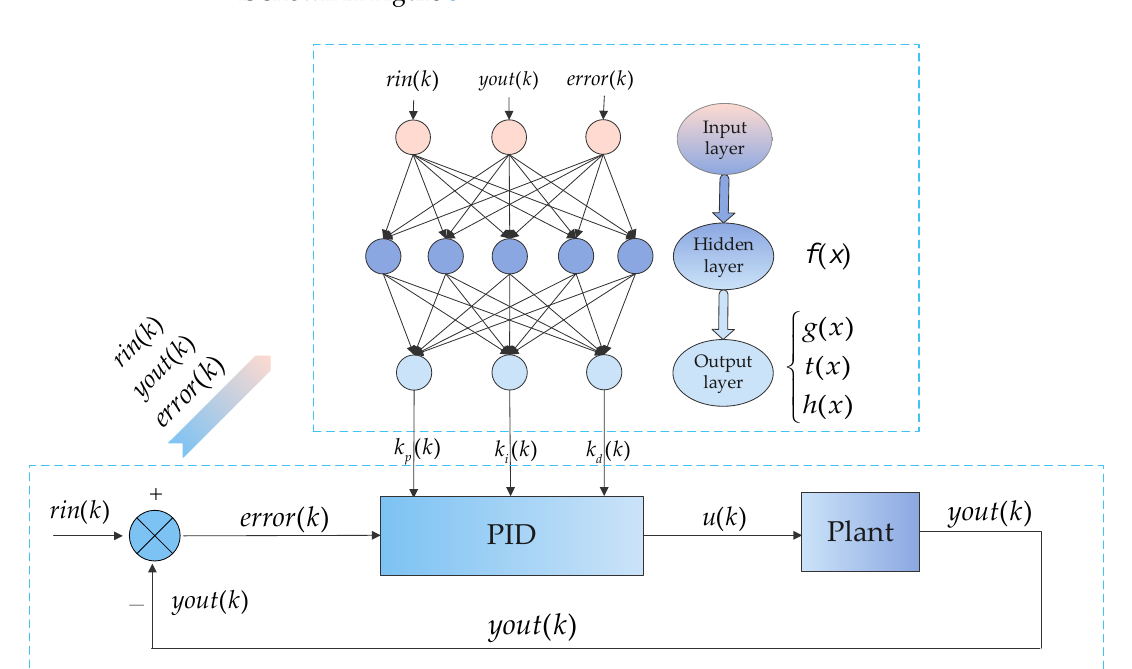
Figure 3. The PID controller structure based on back propagation neural network.